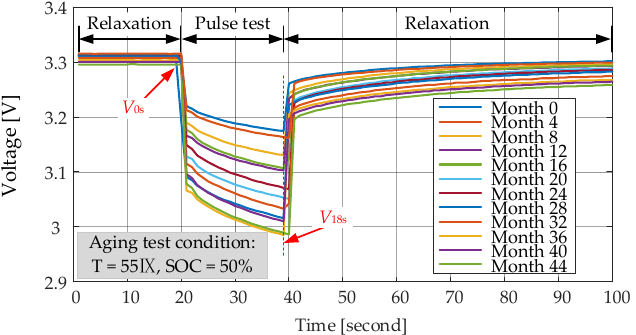
Figure 13. The pulse voltage responses applied to measure the internal resistance of the LiFePO 4 /C battery cell.